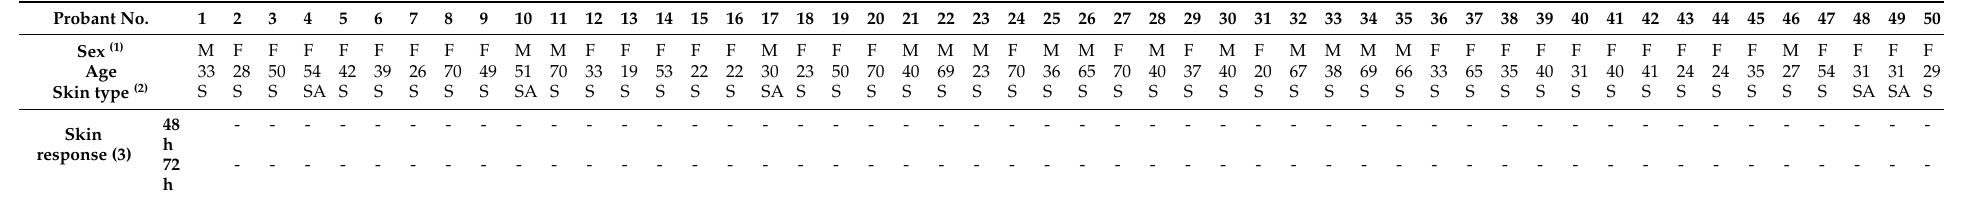
Table 7. Effect of the dye obtained through the LAC-mediated ANS transformation on human